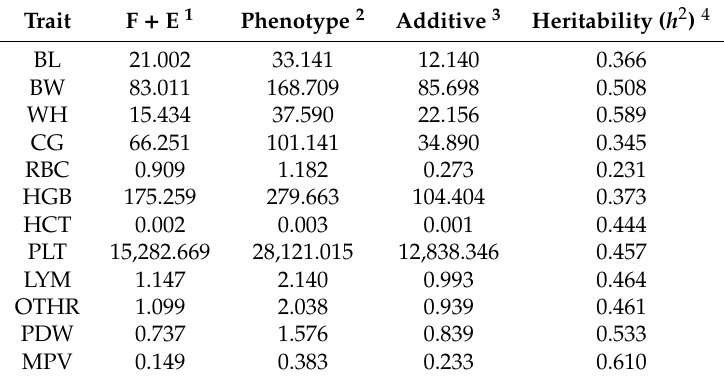
Table 3. Summary of the genetic parameters of di ff erent